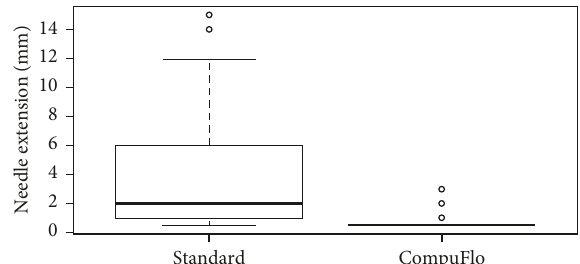
Figure 3: Box plot of the Tuohy needle extension (mm) through a simulated ligamentum flavum during the epidural procedure with the standard technique or with the CompuFlo ® -assisted